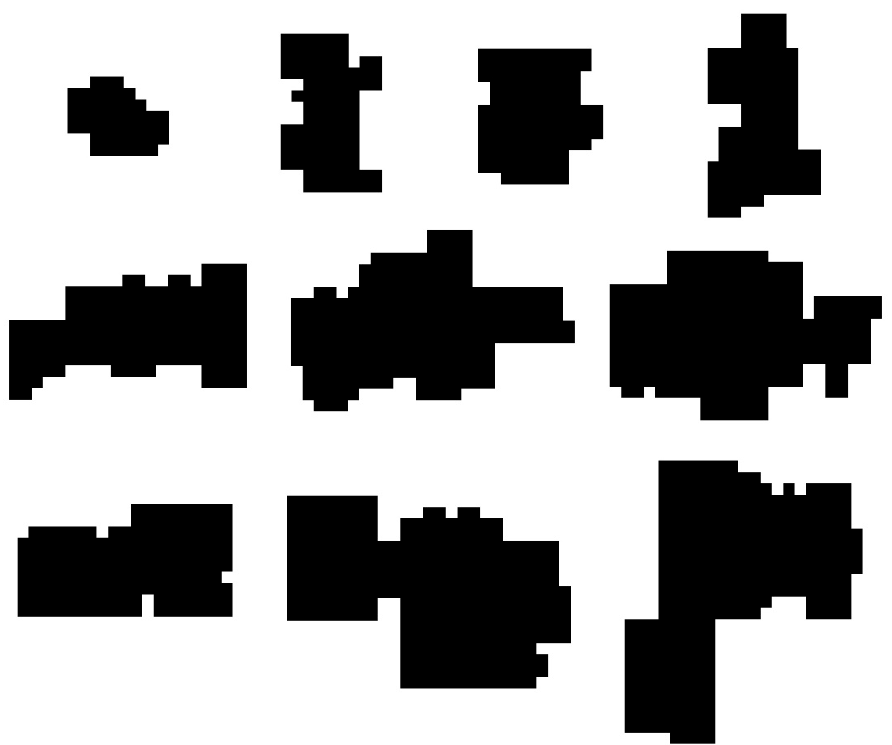
Figure 13. Border shapes of our selection of complex real-life buildings.